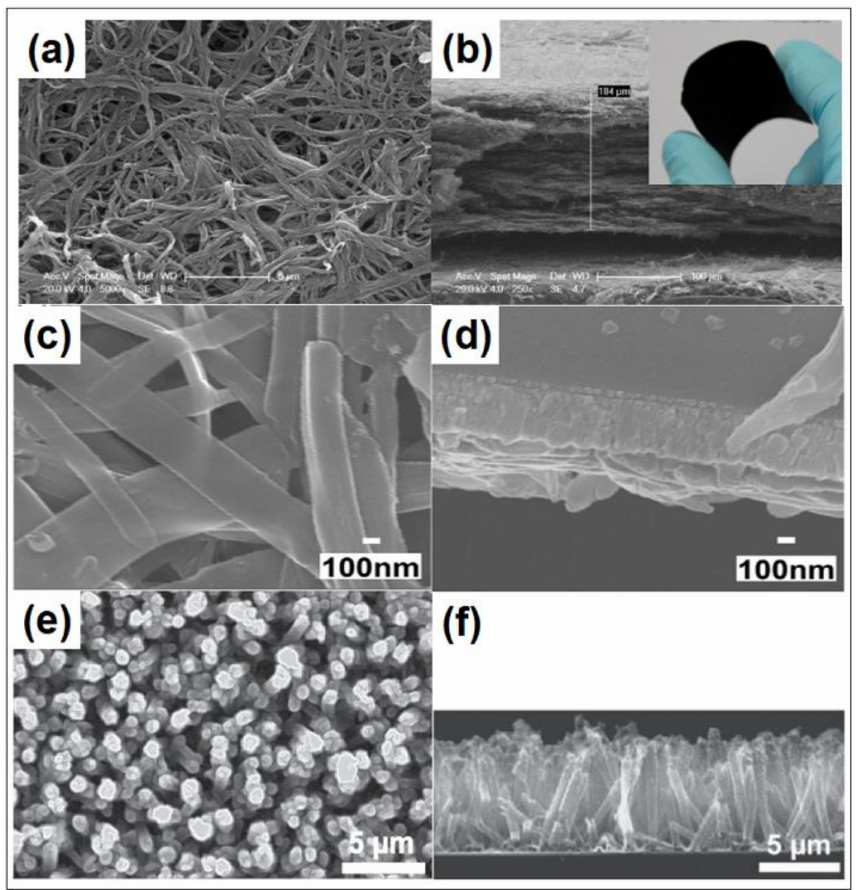
Figure 3. Field Emission Scanning Electron Microscope (FESEM) images and corresponding cross-sectional FESEM images of di ff erent conductive polymers counter electrodes: ( a , b ) Paper-like PPy membrane (reproduced from Reference [76] with permission, copyright American Chemical Society, 2014); ( c , d ) polyaniline (PANI) nanoribbons (reproduced from Reference [83] with permission, copyright Elsevier, 2016); and ( e , f ) PEDOT nanotubes (reproduced from Reference [93] with permission, copyright Wiley, 2011), respectively. Table 3. Photovoltaic performances parameters of DSSCs based on the PEDOT counter electrodes. Preparation Methods